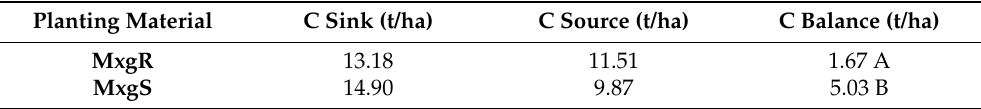
Table 2. Carbon balance within the plant pool in relation to the different planting